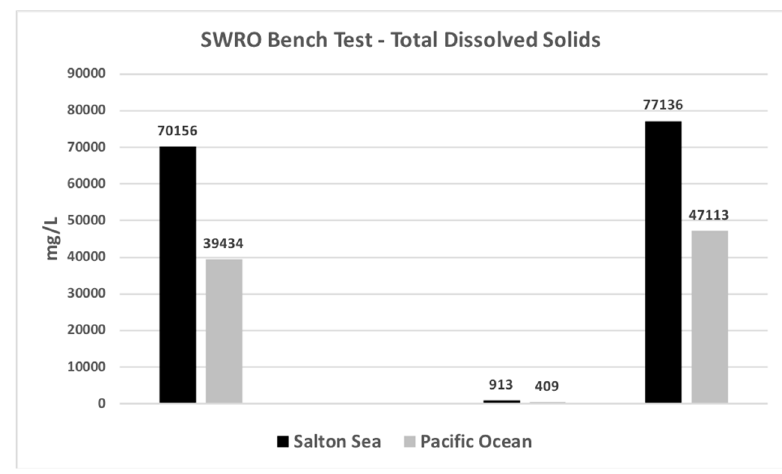
Figure 9. Conductivity of raw water, SWRO feed, permeate, and reject flow.